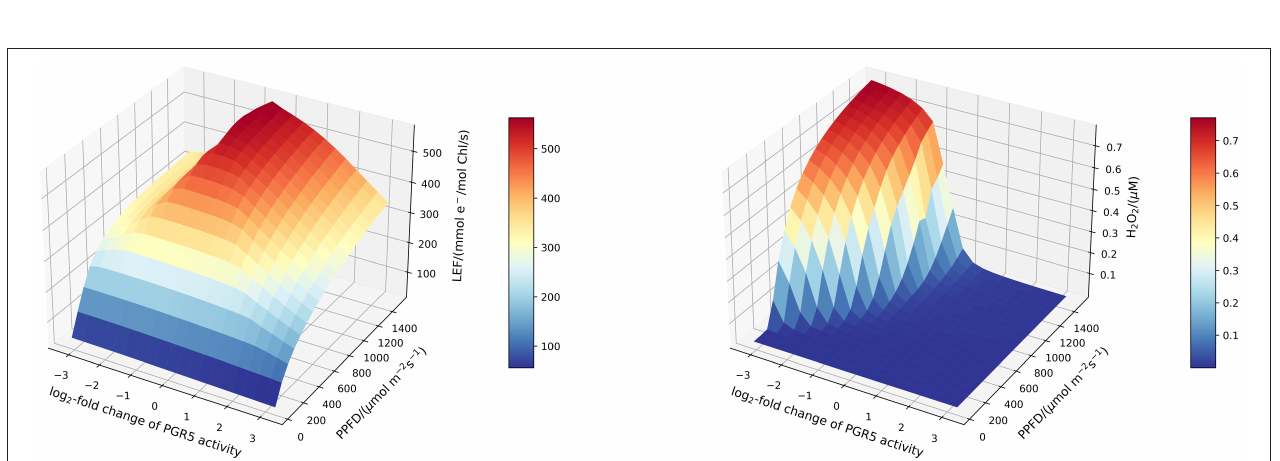
FIGURE 6 | Results of the MCA. Flux (left) and concentration (right) control coefficients of representative reactions of photosynthesis in high and low light conditions. The top panels show the distribution of control under high light (PPFD 1,000 µ molm − 2 s − 1 ), the bottom panels under low light (PPFD 100 µ molm − 2 s − 1 ). For all panels, on the x-axis we marked the perturbed parameters. The parameters are perturbed by ± 1% and the resulting effect on steady state values is monitored for the quantities on the y-axis. It can be clearly seen how the control of photosynthesis shifts from the supply side in low light (bottom) to the demand side under high light, exhibiting striking control of SBPase (top) .